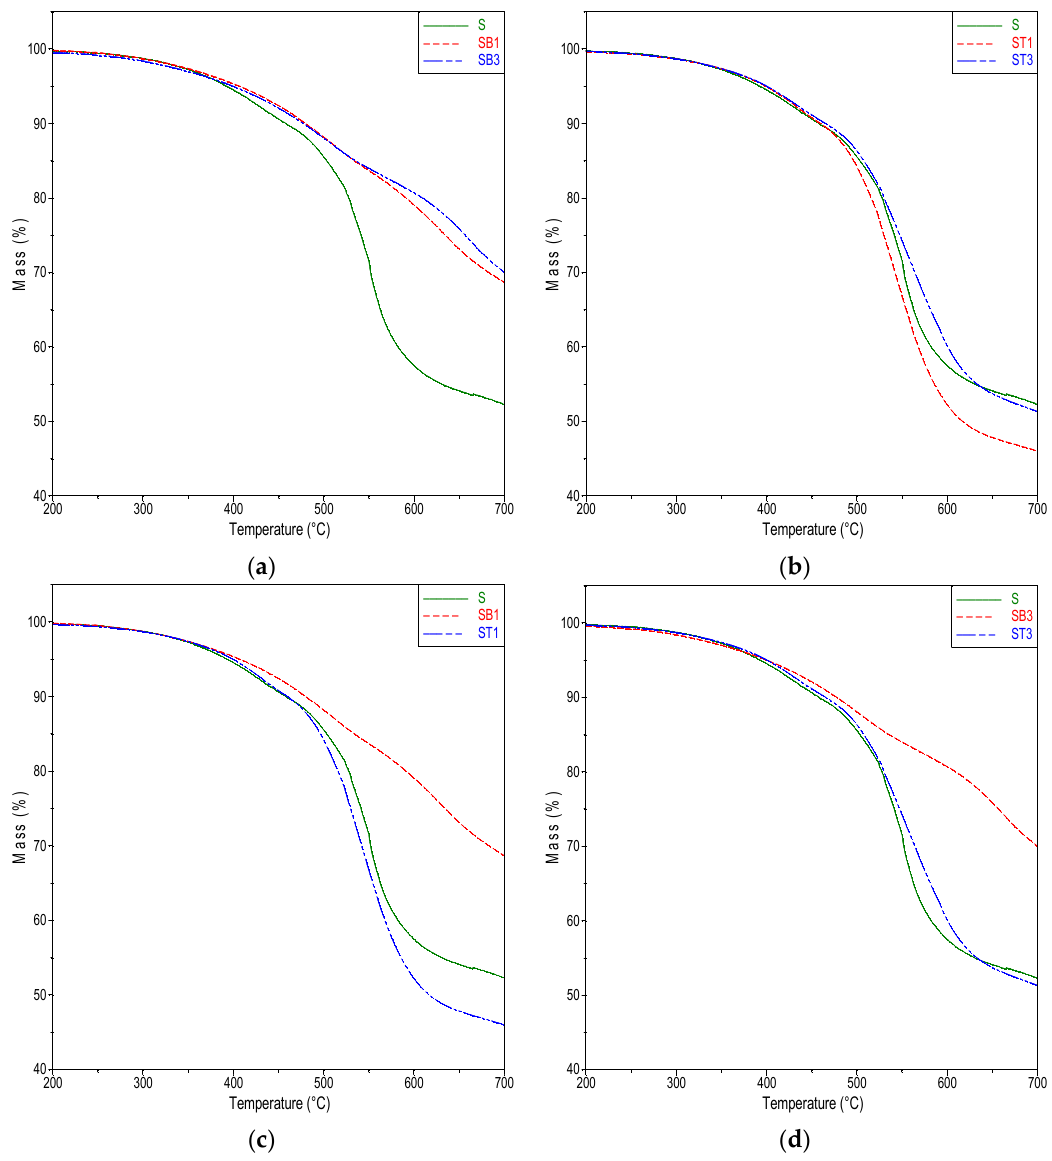
Figure 7. Thermogravimetric curves for unfilled polymeric matrix (S) and its composites filled with: (a) diatomaceous biosilica, (b) talk, (c) the 1% wt and (d) 3% wt of different fillers